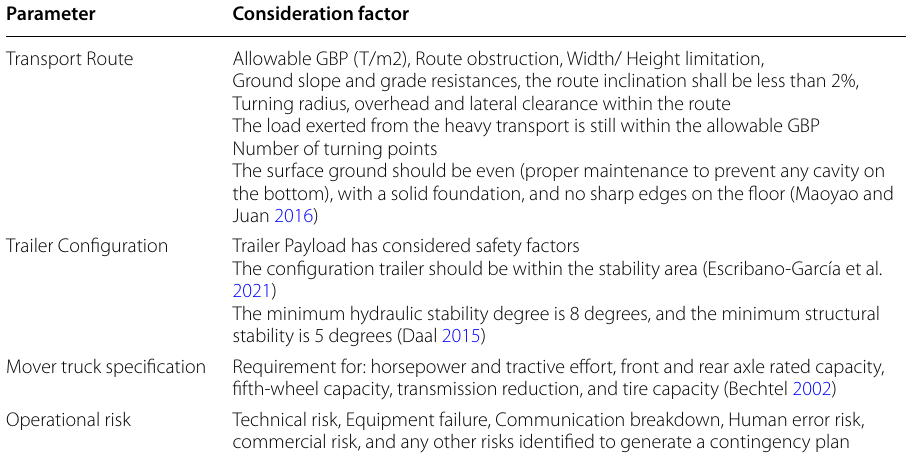
Table 6 Heavy haulage consideration factors (Author’s